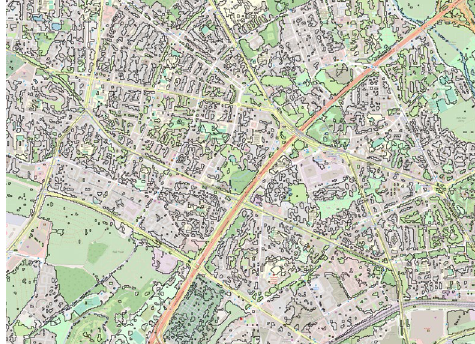
Fig. 4. Comparison of mapped impervious surface based on NDVI with Open street map.